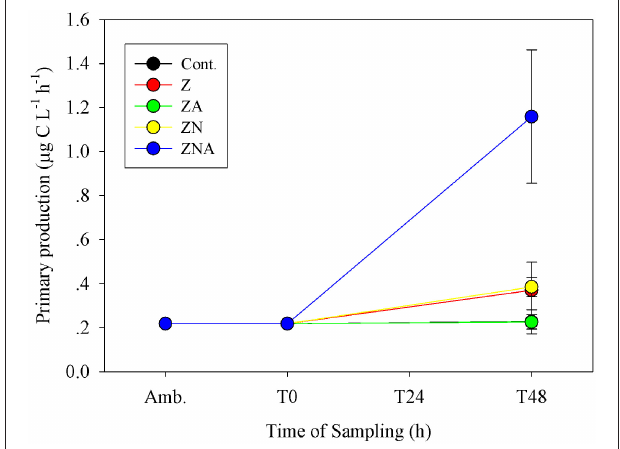
FIGURE 5 | Measured changes in calculated Synechococcus biomass determined by flow cytometry in the microcosm treatments compared with the initial values at the beginning of the experiment.